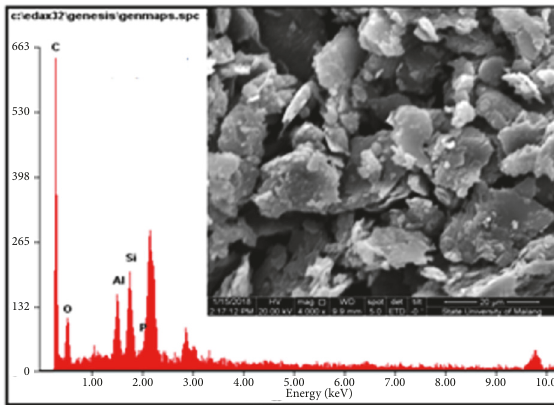
Figure 6: SEM EDX of